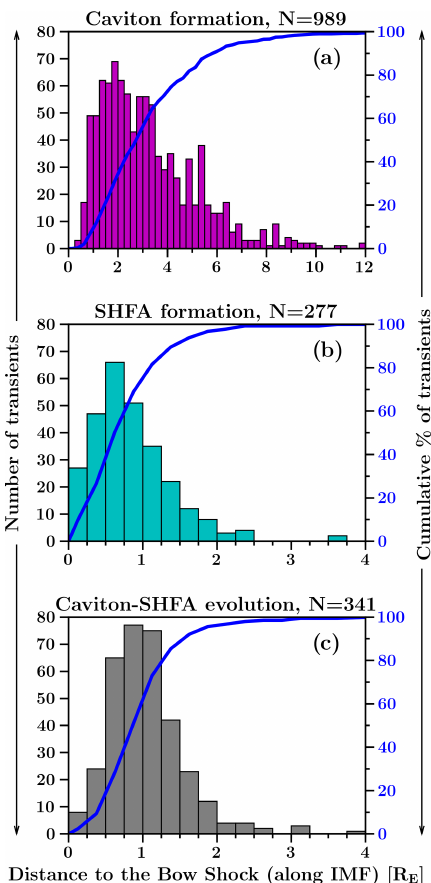
Figure 4. Distributions of (a) the caviton formation locations, (b) the SHFA formation locations and (c) the locations where caviton-to-SHFA evolution takes place as a function of the distance to the bow shock along the IMF direction (45 ◦ angle from the Sun– Earth line). The blue curve in each panel shows the cumulative dis-